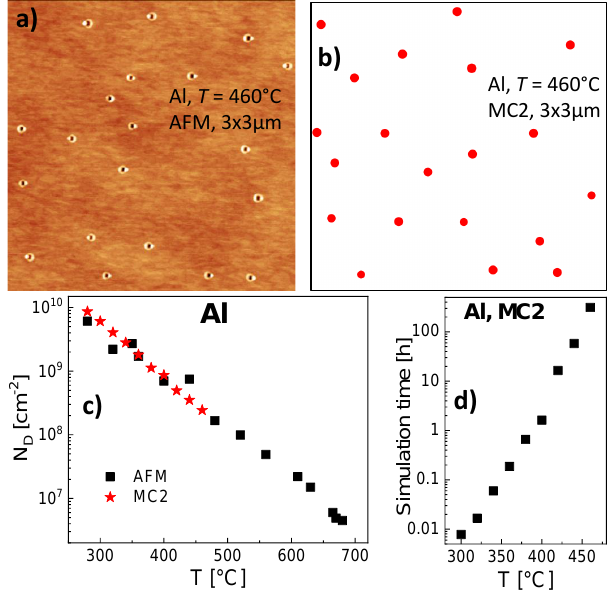
Figure 6. ( a ) 3 × 3 µm AFM image of an AlGaAs surface after Al droplet deposition at T = 460 °C. At this temperature, the deposited droplets are transformed into nanoholes during post-growth annealing (droplet etching). ( b ) Surface with Al droplets simulated using the MC2 model with E S = 0.19 eV, E E = 1.44 eV on a 7500 × 7500 field (3 × 3 µm). ( c ) Comparison of experimental Al droplet densities with simulation results obtained using MC2. ( d ) Time needed for a simulation run as function of the modeled process